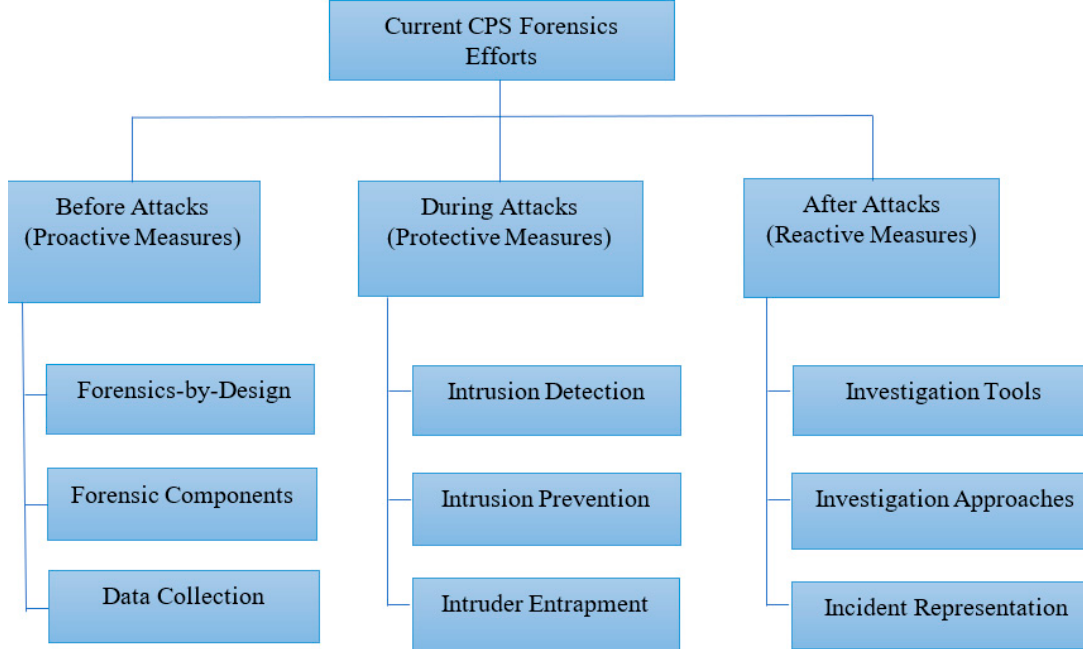
Figure 5. Current CPS Forensics Research Efforts Categories. Table 3. A Summary of Current Research Efforts for CPS Forensics.